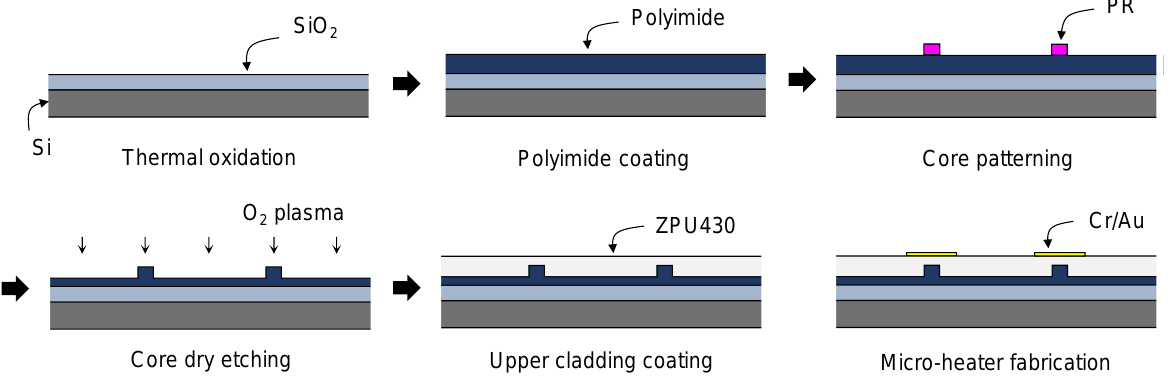
Figure 2. Schematic description of the device fabrication procedures.